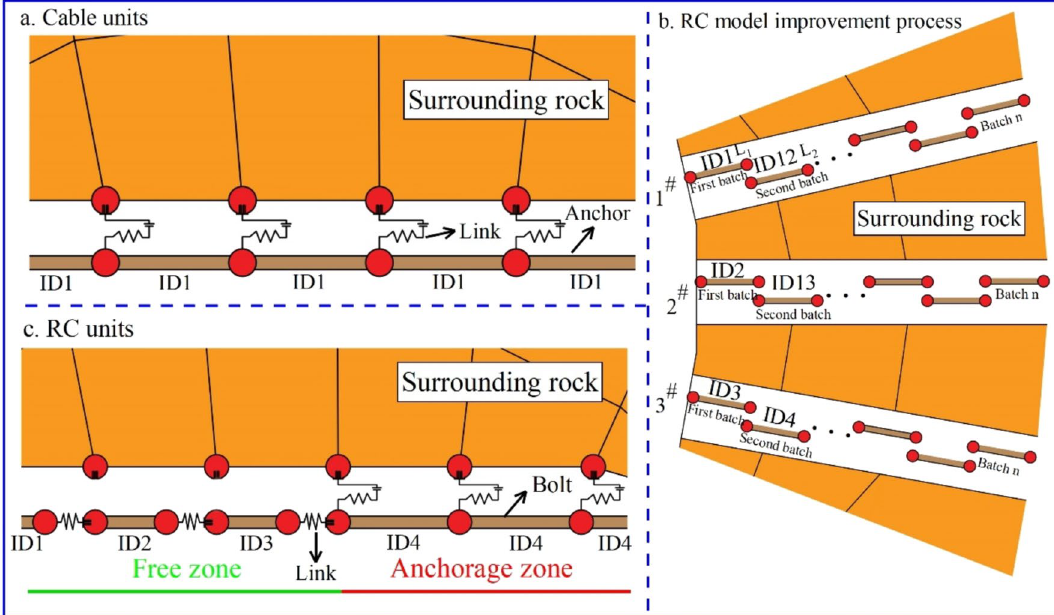
Figure 5. Construction process and mechanical model of the RC